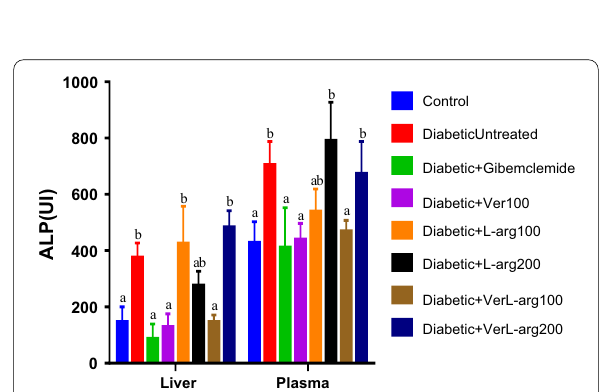
Fig. 15 Alkaline phosphatase activity in diabetic mice treated with verbenone, L-arginine and ratios of verbenone after 14 days treatment. Values are expressed as mean Values with different superscripts are significantly different at p < 0.05. VerL-arg verbenone L-arginine (1:1 = +